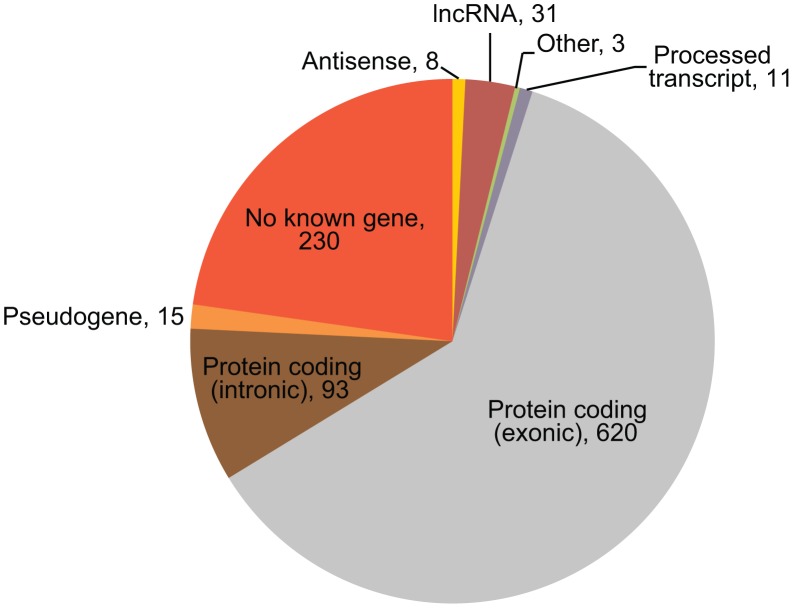
Mapping regions of cis-regulated tags.The gene biotypes and exon/intron locations of unique cis-regulated tags, according to Ensembl v.69 annotation, are shown. The numbers indicate the number of tags mapping in the genes of the corresponding type.